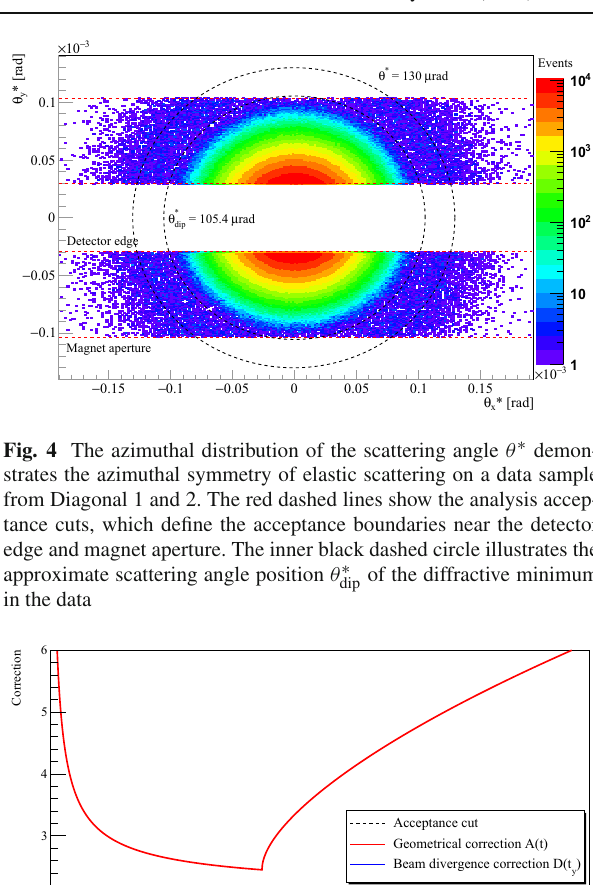
Δ y = y − y far near with so-called spectrometer cuts, see Table 1. The equality of the horizontal vertex position x ∗ reconstructed from the left and right arms is also required.